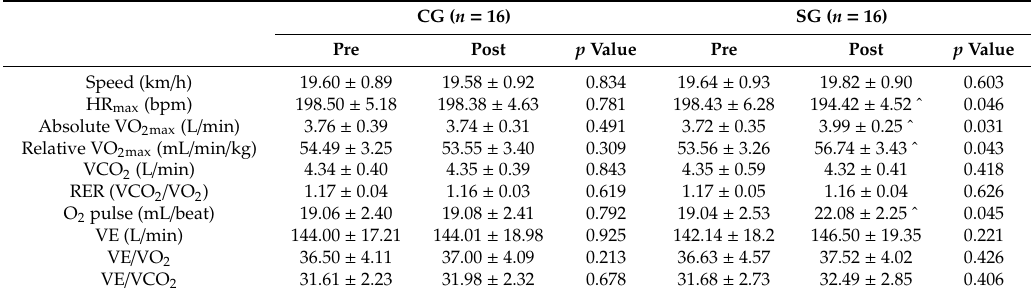
Table 6. Maximum values of the incremental test in both